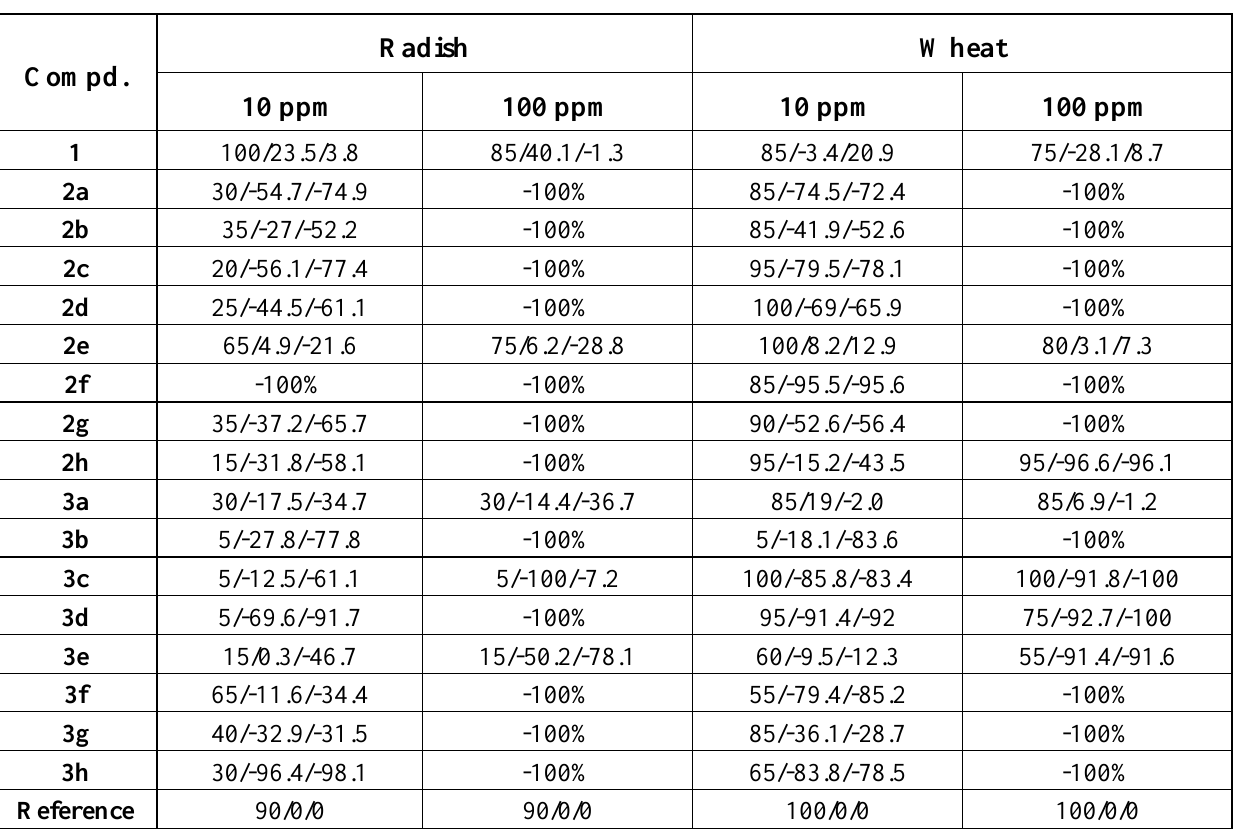
Table 1. Plant growth regulating activities of compounds 1, 2a~2h , 3a ~